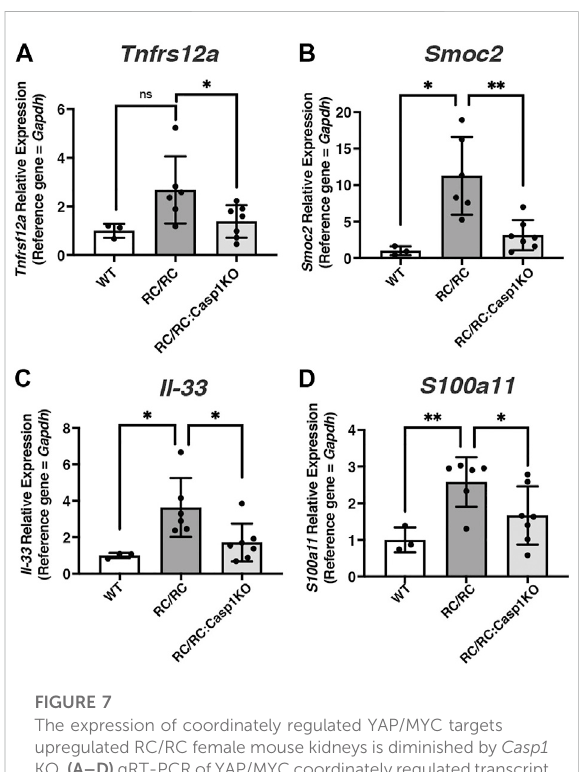
The expression of coordinately regulated YAP/MYC targets upregulated RC/RC female mouse kidneys is diminished by Casp1 KO. (A – D) qRT-PCR ofYAP/MYC coordinately regulated transcript targets from WT, RC/RC, and RC/RC: Casp1 KO female